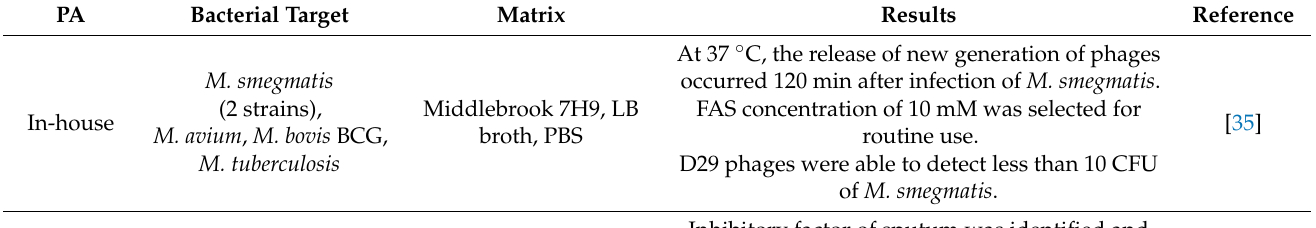
Table 1. Optimization and evaluation of phage amplification assay for the detection of mycobacteria significant in human medicine using artificial contamination of